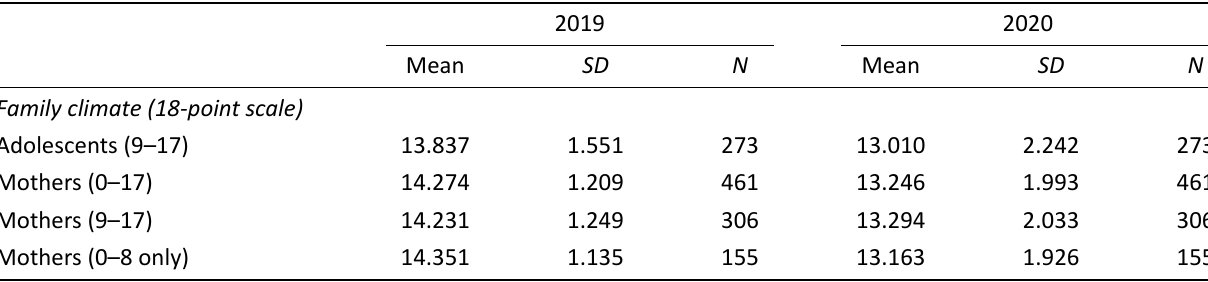
Table 1. Summary